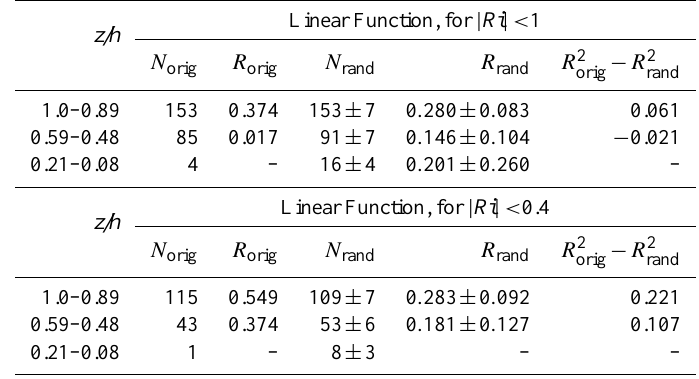
Table 4. Self-correlation analysis between the local flux-profile relationship of temperature, φ h , and local bulk Richardson number, Ri , in forest canopy, for linear relation with | Ri | < 1 and | Ri | < 0.4. Linear Function, for | Ri | < 1 z/h − R 2 N orig R orig N rand R rand R 2 orig rand 1.0–0.89 153 0.374 153 ± 7 0 . 280 ± 0 . 083 0.061 0.59–0.48 85 0.017 91 ± 7 0 . 146 ± 0 . 104 − 0.021 0.21–0.08 4 – 16 ± 4 0 . 201 ± 0 . 260 Linear Function, for | Ri | < 0.4 z/h N orig R orig N rand R rand 1.0–0.89 0.221